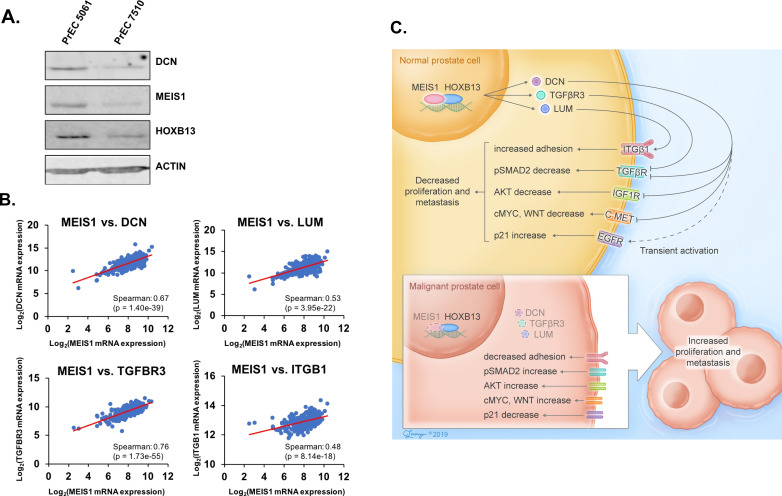
Increased proteoglycan expression within human prostate tumors that retain MEIS1/2 expression.(A) Western blot analysis of MEIS1 and DCN expression in protein lysates from primary prostate epithelial cells (PrECs). Actin was used as a loading control. (B) Correlation of mRNA expression level of MEIS1 with DCN, TGFBR3, LUM, or ITGB1 in RNA-seq data of prostate tumors from The Cancer Genome Atlas (TCGA; RNA-seq V2 RSEM) (Abeshouse et al., 2015). Analysis was performed using the online tool cBioPortal (Cerami et al., 2012). (C) Schematic of Results. Within normal prostate epithelial cells, MEIS1 complexes with HOXB13 to maintain expression of proteoglycans such as DCN, LUM, and TGFBR3 and repress growth factor and migration/invasion signaling through RTKs. As a cell transforms to a malignant state, MEIS1/2 are epigenetically silenced in more aggressive prostate tumors and expression of tumor-suppressive proteoglycans is suppressed, leading to decreased regulation of oncogenic signaling through pathways such as TGFβ, EGFR, cMYC, WNT, and IGF1R.